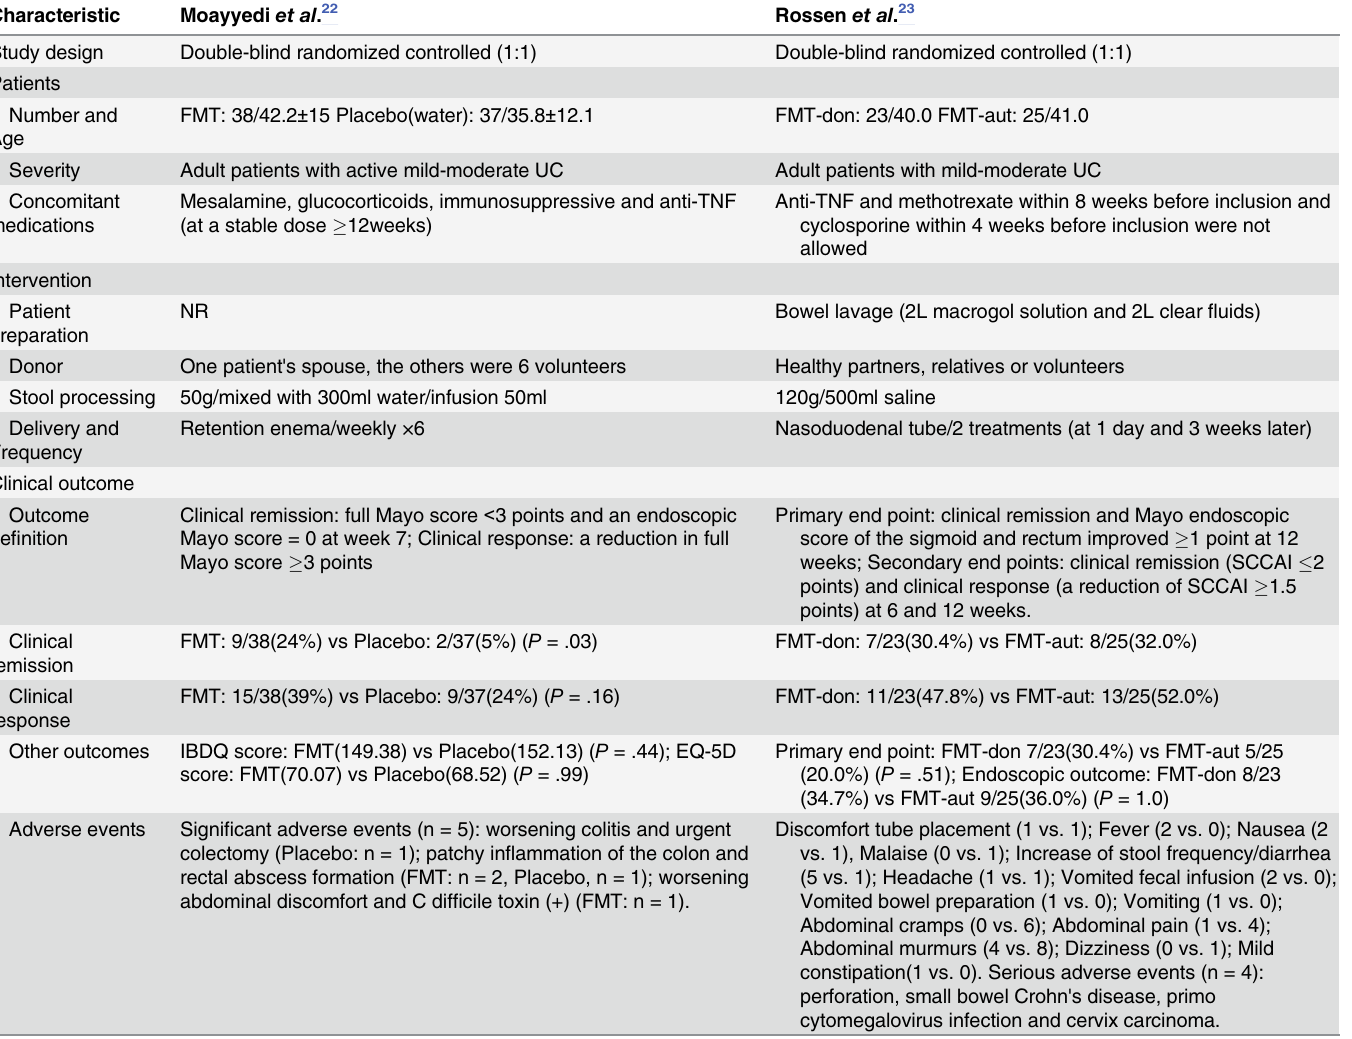
Table 4. Characteristics of randomized controlled